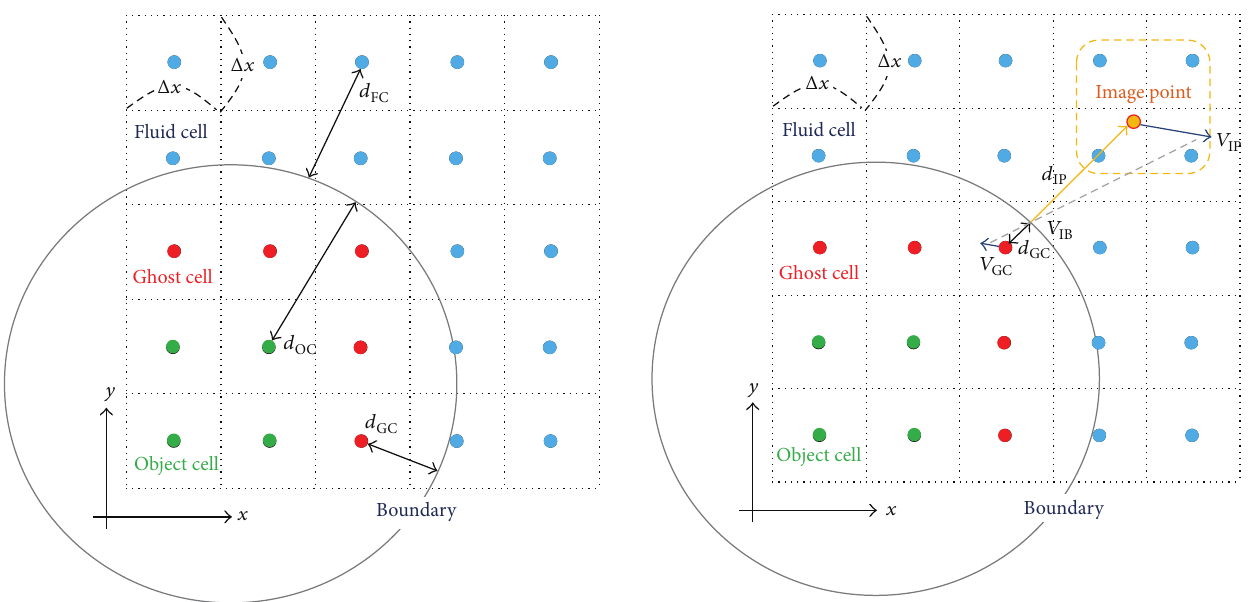
Figure 3: Schematic of the present ghost cell approach with image point.